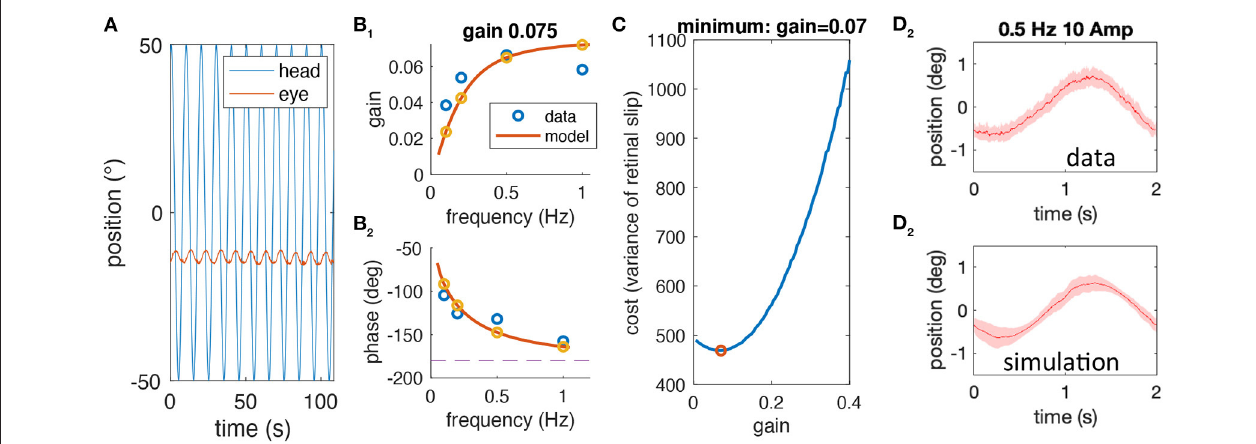
FIGURE 2 | Sequential steps of the methodological approach. (A) Example of raw head (blue) and eye (red) motion data obtained from one animal at a stimulus frequency of 0.1Hz. (B) gain (B 1 ) and phase values (B 2 ) derived from raw data (blue) for a single animal along with the model simulation of the best fitting model; the gain value for this animal is 0.075. (C) Simulated cost function (retinal image slip variance) plotted with respect to the gain factor using the model derived in (B) for different noise factors; here, the simulation is shown for the optimal gain factor that matches the animal’s actual gain factor. (D) Averaged eye position response during rotation at 0.5Hz for the data (D 1 ) and the simulation (D 2 ) ; note that the average eye position trace of data and simulation (mean, red line) is similar due to the prior model fitting, but that the variability, which is also similar (shaded red) is a prediction based on the noise level and gain